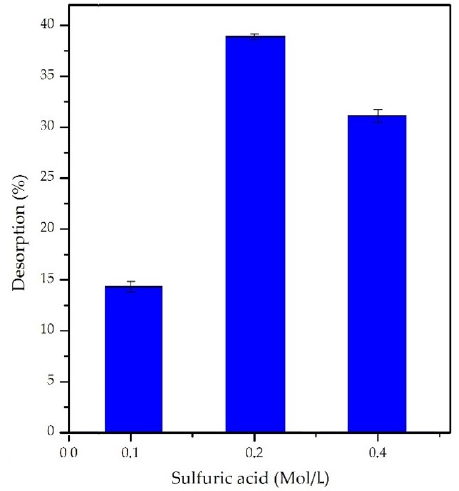
Figure 11. Desorption of Cu(II) from the modified zeolite.